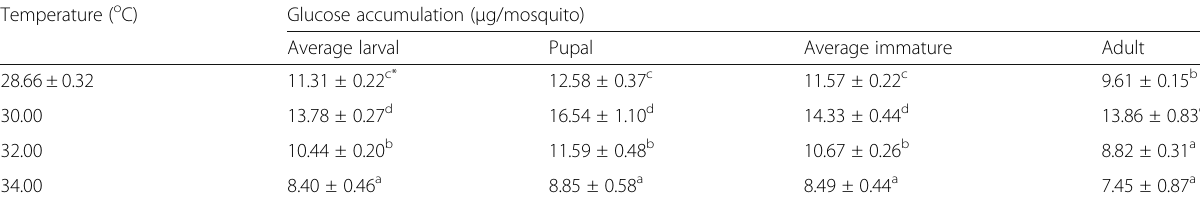
*Within a column, means (±SD) followed by same letter are not significantly different at p <0.05 according to Duncan multiple range test following analysis of variance